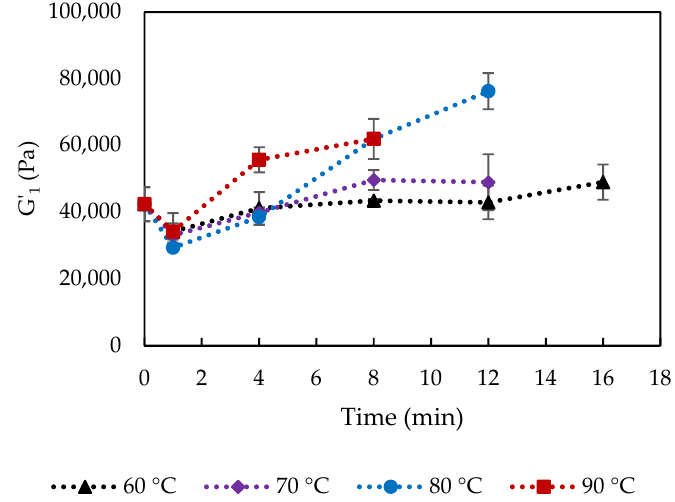
Figure 7. Storage modulus at 1 Hz (G ′ 1 ) of curd cooked at varied conditions. The error bars indicate standard deviations.